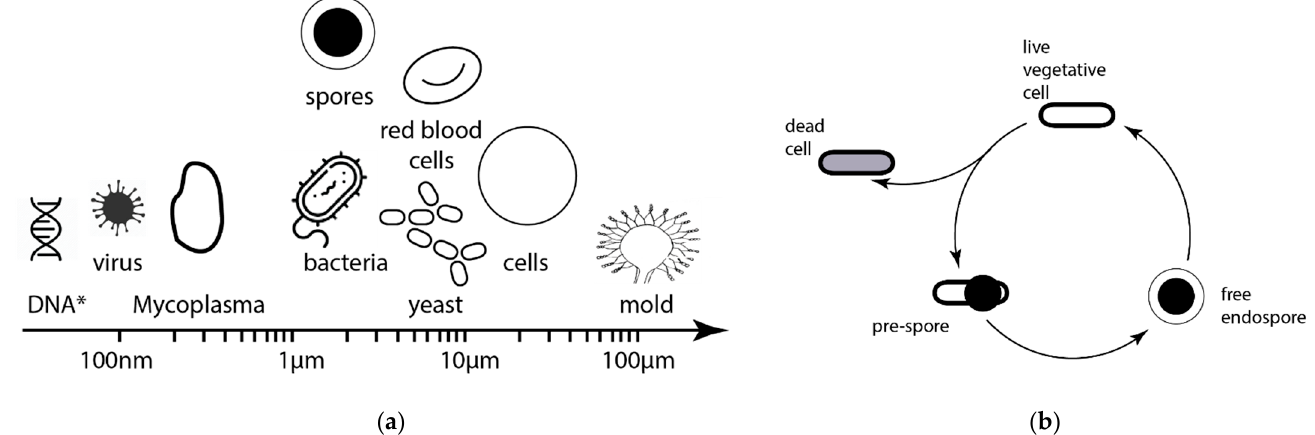
Figure 3. The Fluid-Screen technology is universal and can capture and separate different species of bacteria, fungi, and viruses from various sample matrices. ( a ) FS technology captures and separates diverse life forms. * Capturing of DNA and other large biomolecules has been demonstrated in the literature [21,22] and it is not a direct focus of Fluid-Screen, although FS technology could be adapted to capture large biomolecules as well. ( b ) FS technology can also differentiate between different physiological stages of life and can selectively capture life forms at their different physiological stages.